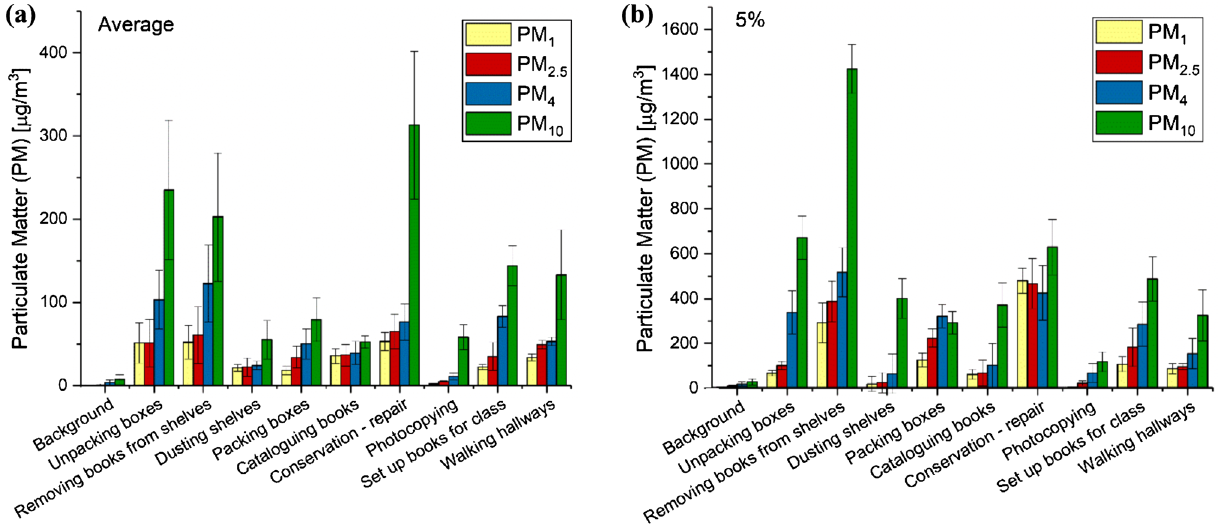
exposure levels are not shown since much higher than detected , PM , 1 2.5 PM levels (for PM and PM , the TWA 8-h exposure limits are 15 2.5 10 and 5 mg/m 3 ,